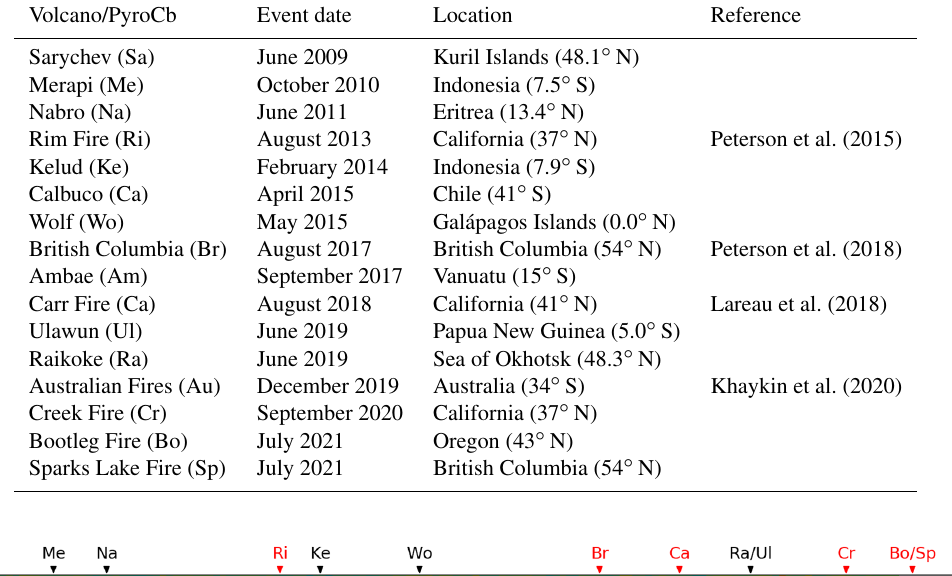
Table 1. Most significative volcanic eruptions (volcanic explosivity index (VEI) > 4) and PyroCb events affecting measurements over TMF, Payerne, and Reunion Island for the period comprehended between January 2009 and November 2022. Information regarding the location of the erupting volcanos and their VEI was retrieved from the Global Volcanism Program (https://volcano.si.edu/, last access: 22 November 2021). In the case of the PyroCbs, available references are included in the last column.